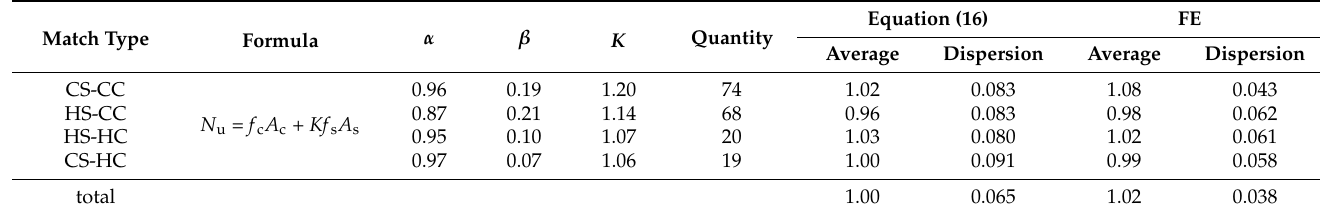
Table 2. Parameter value and comparison of steel constitutive model.